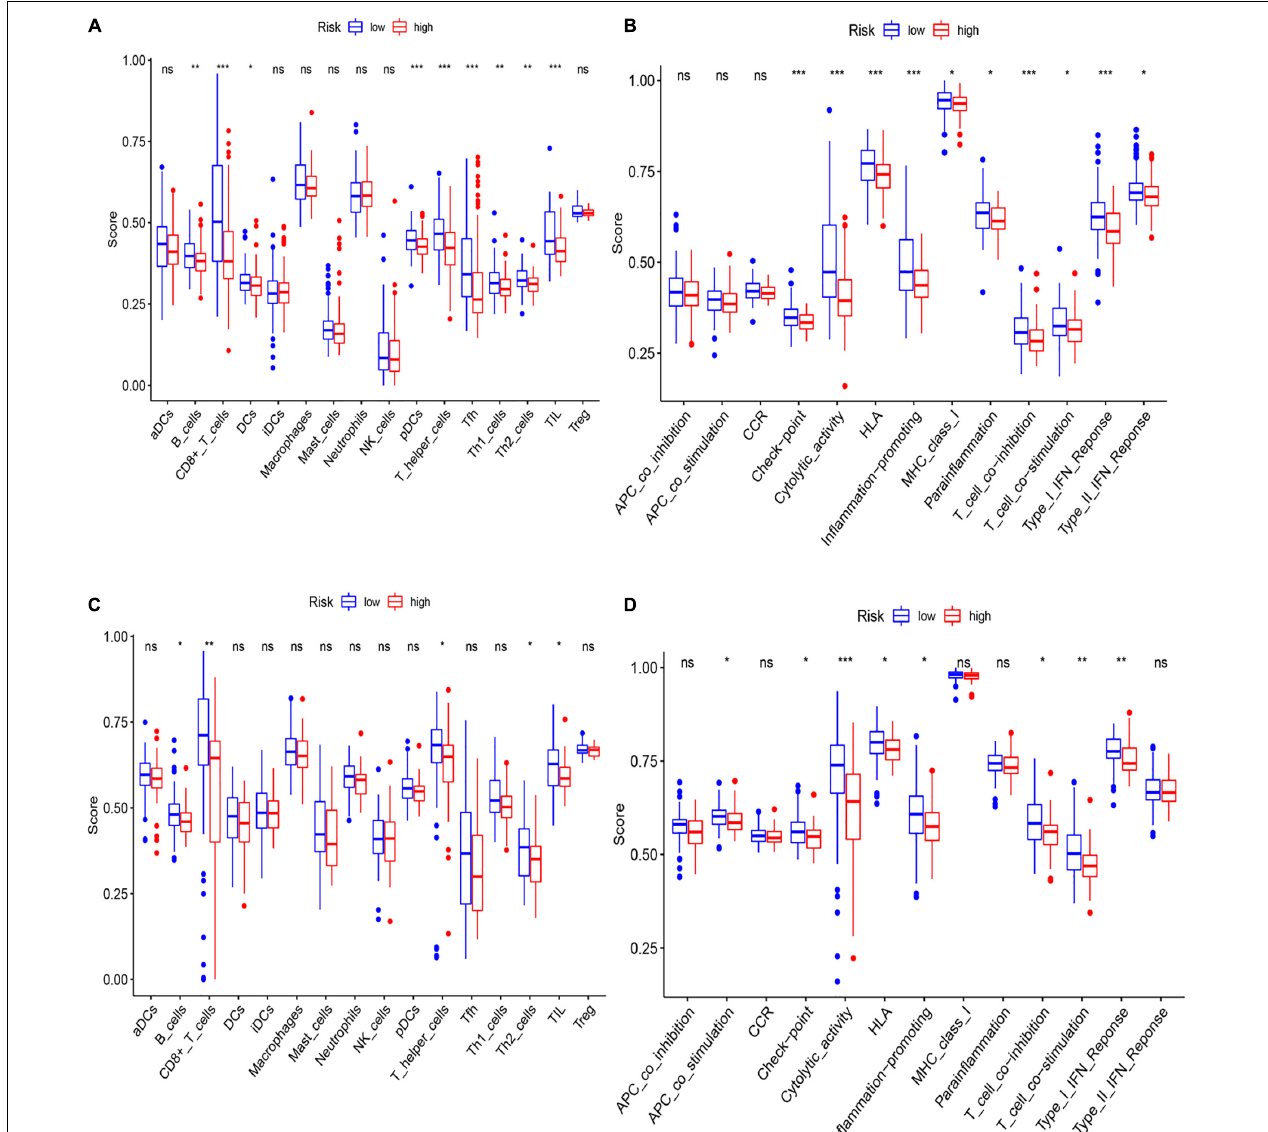
FIGURE 7 | Analysis of immune status between low- and high-risk subgroups. (A,B) The enrichment scores of 16 immune cells (A) and 13 immune-related functions (B) of two subgroups in the training cohort. (C,D) The enrichment scores of 16 immune cells (C) and 13 immune-related networks (D) of two subgroups in the validation